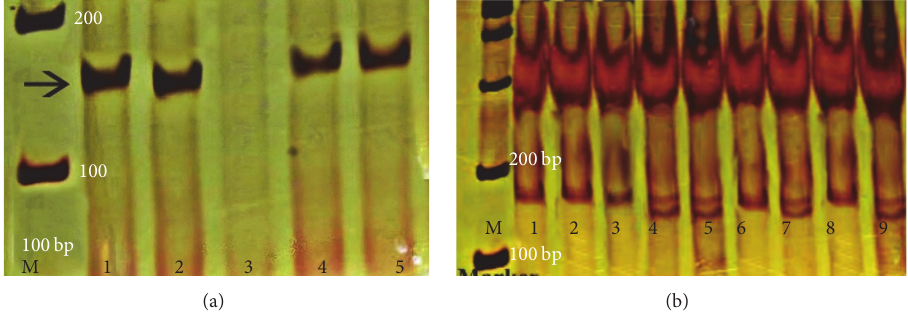
Figure 1: (a) PCR product of IL gene corresponding to a 156 bp band; M: 100bp DNA ladder, lane 3: negative control, lanes 1, 2, 4, and 5: samples. (b) Genotyping of IL polymorphism by PCR-RFLP, M: 100 bp DNA ladder; subjects 1, 2, 3, 6, and 8: homozygotes for the G allele;